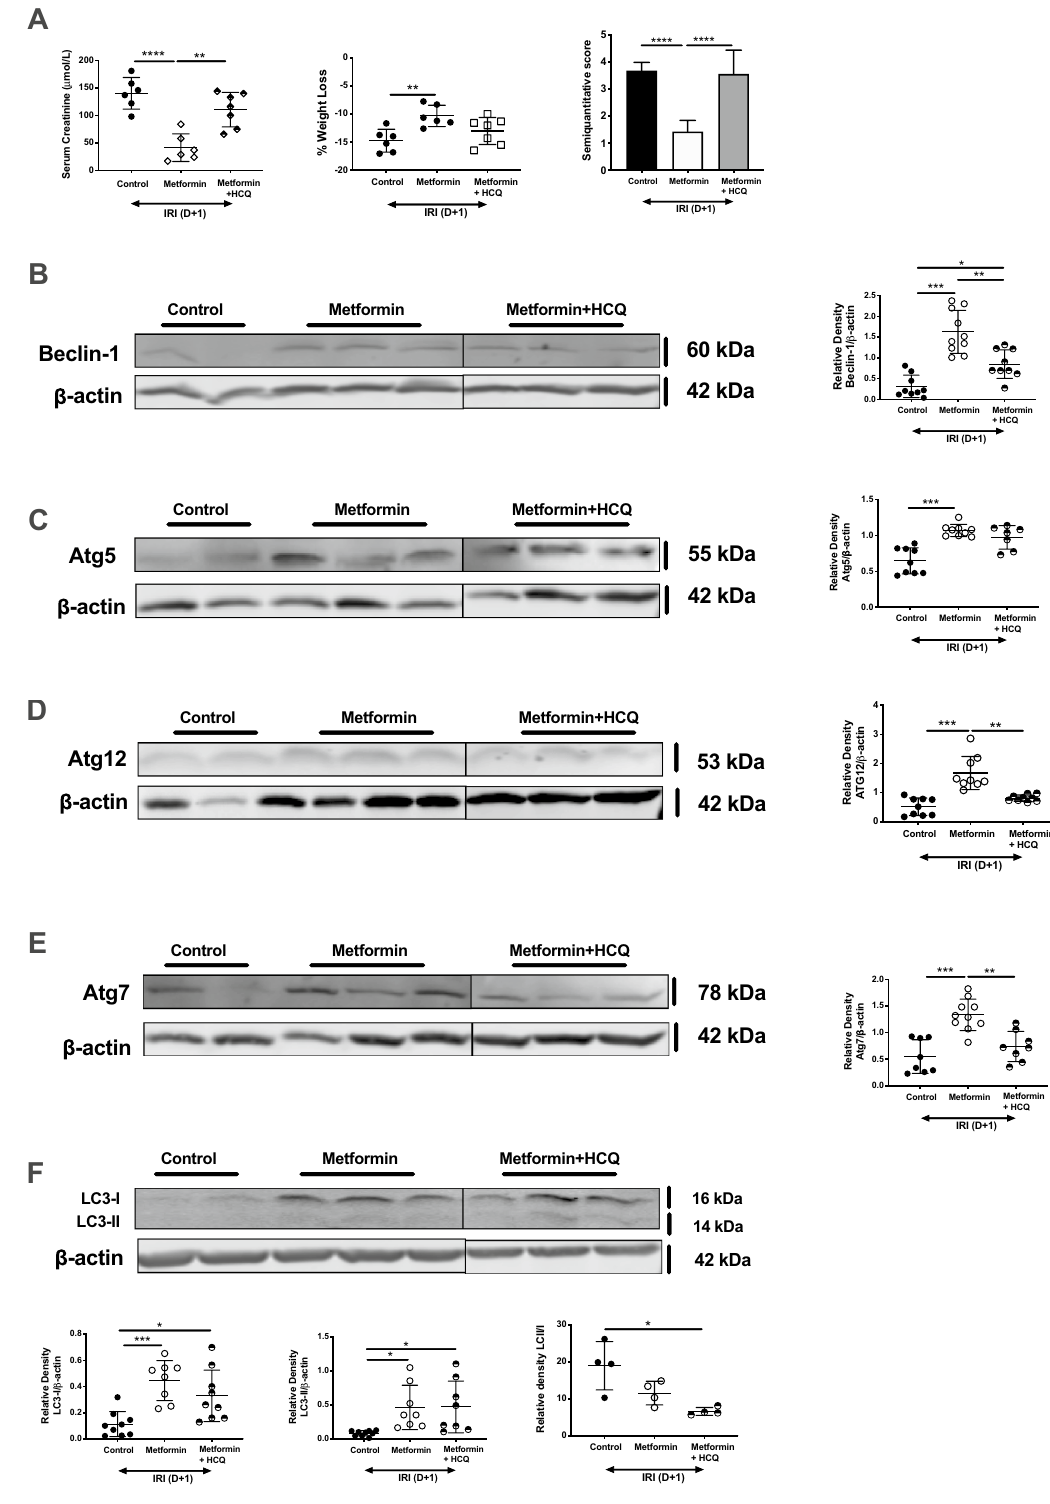
Figure 3. Metformin limits autophagy in acute kidney injury. Age-matched male C57BL/6 mice were administered vehicle control (phosphate buffered saline, PBS), metformin, or metformin and hydroxychloroquine and then subjected to bilateral renal ischemia followed by 24 h reperfusion. ( A ) Serum creatinine, ( B ) change in weight and ( C ) semiquantitative analysis of tissue injury were recorded. Kidney tissue homogenates were prepared and protein separated by SDS-PAGE. Representative Western blots and combined densitometry from groups for ( A ) Beclin-1, ( B ) Atg5, ( C ) Atg12, ( D ) Atg7 and ( E ) LC3I/II from n = 5–7 mice are shown. Densitometry is presented as the mean ratio of target protein to β-actin ± SD; * p < 0.05, ** p < 0.01, *** p < 0.001, **** p <